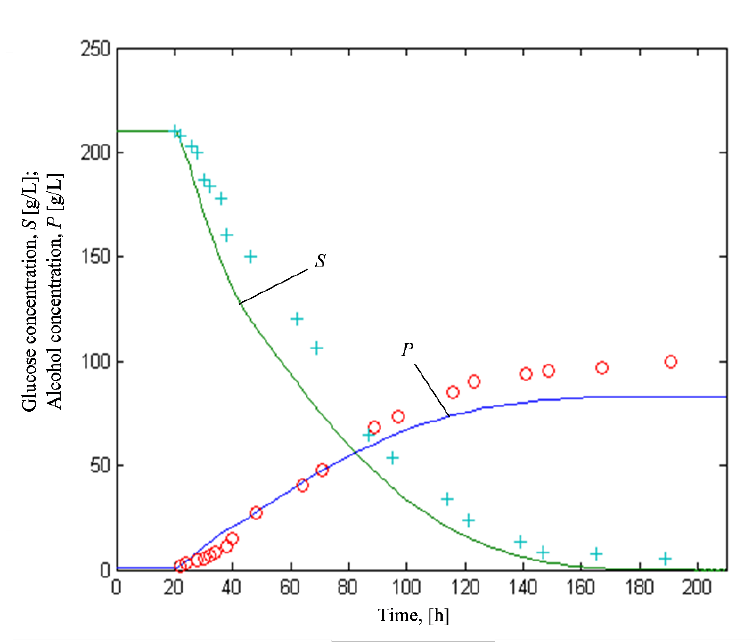
Figure 12. Evolution of glucose and alcohol concentrations; a comparison between experimental values (( o )—glucose and ( + )—alcohol) and simulation results (continuous lines).